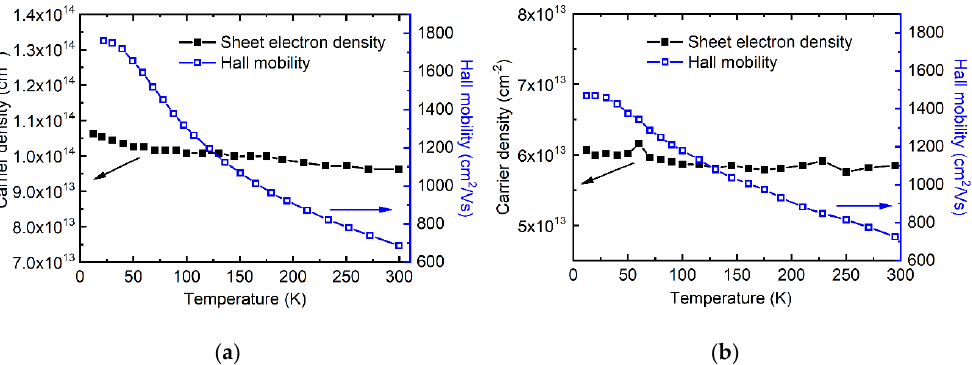
Figure 6. Sheet carrier density and mobility as a function of temperature for the Bi 2 Se 3 film on mica substrate. ( a ) is without and ( b ) is with a buffer layer.